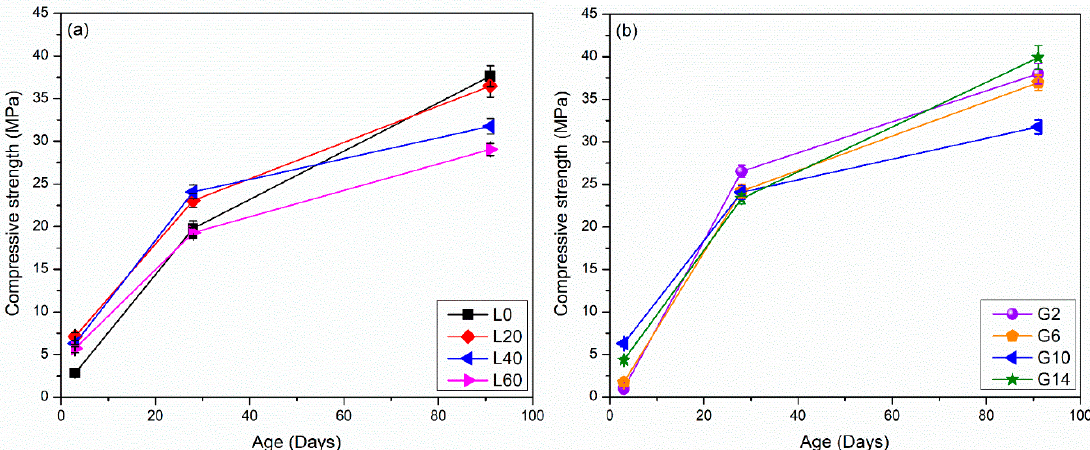
Figure 3. Compressive strength evolution of pastes ( a ) group L mixtures and ( b ) group G mixtures. Error bars on each side are equal to one standard deviation of the mean.